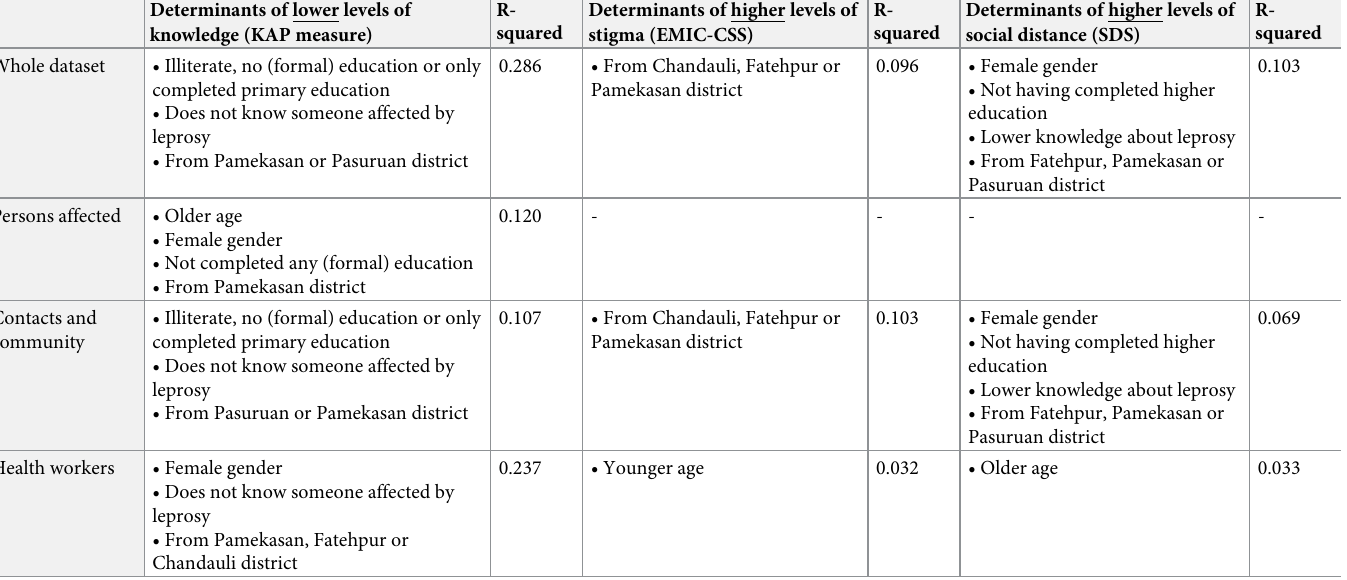
Table 3. Correlations between level of knowledge (KAP score, in the presence of incorrect answers) about leprosy, community stigma (EMIC-CSS), social distance (SDS) and the other variables in the dataset per participant group. Full models can be found as supporting information file (S1 Text). Determinants of lower levels